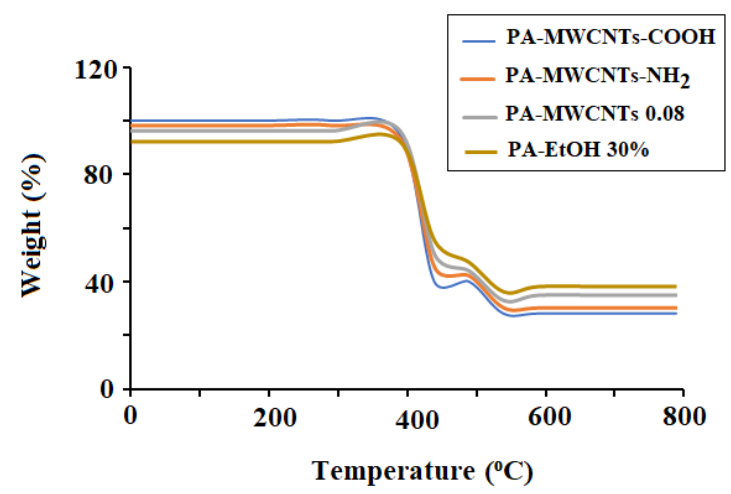
Figure 3. TGA PA-MWCNTs, PA-MWCNTs − COOH and PA-MWCN